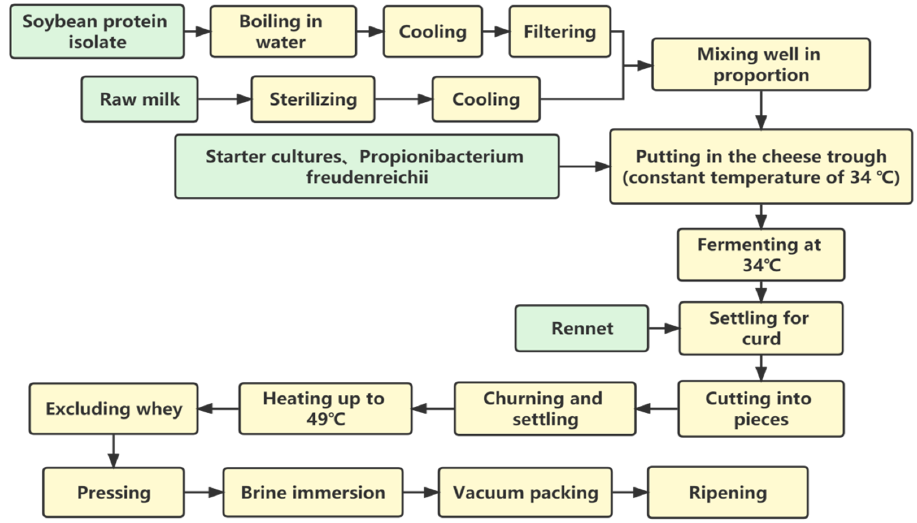
Figure 2. Process flow chart showing the production of mixed soybean cheese using soybean protein isolate and milk.